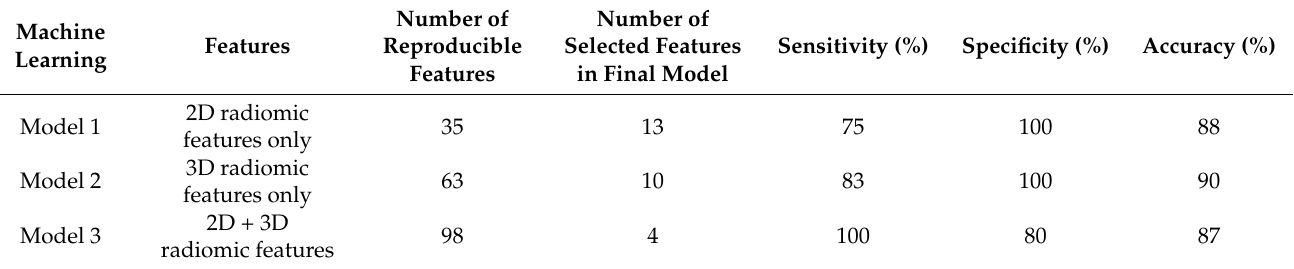
Table 5. Comparing diagnostic accuracy of machine-learning models between 2D and 3D tumor